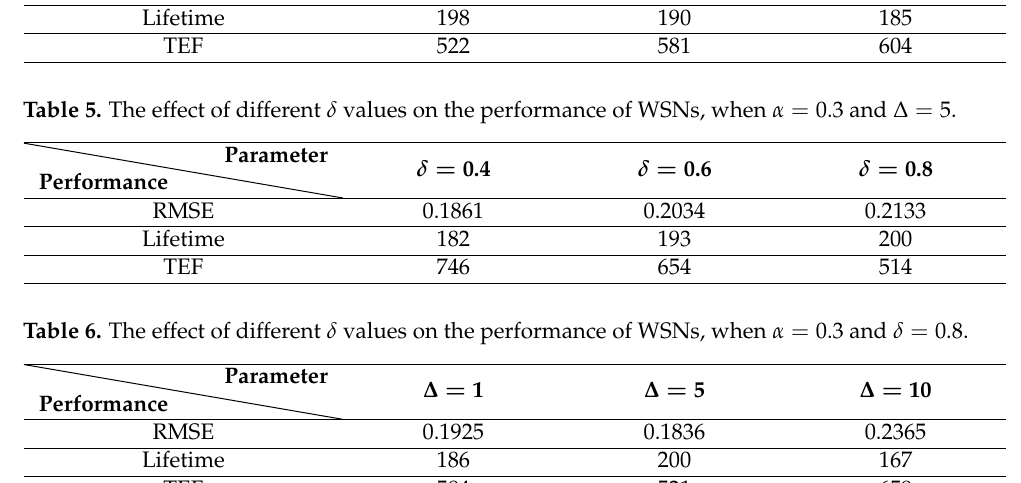
Table 4. The effects of different α values on the performance of WSNs, when δ = 0.8 and ∆ = 5. Performance